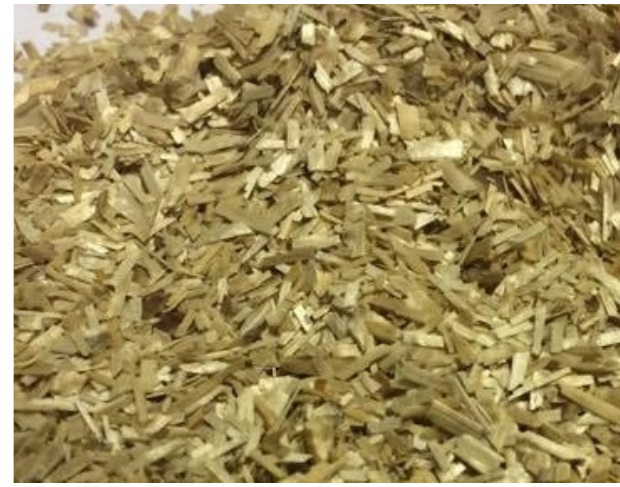
Figure 1. Crushed and sifted flax shives.